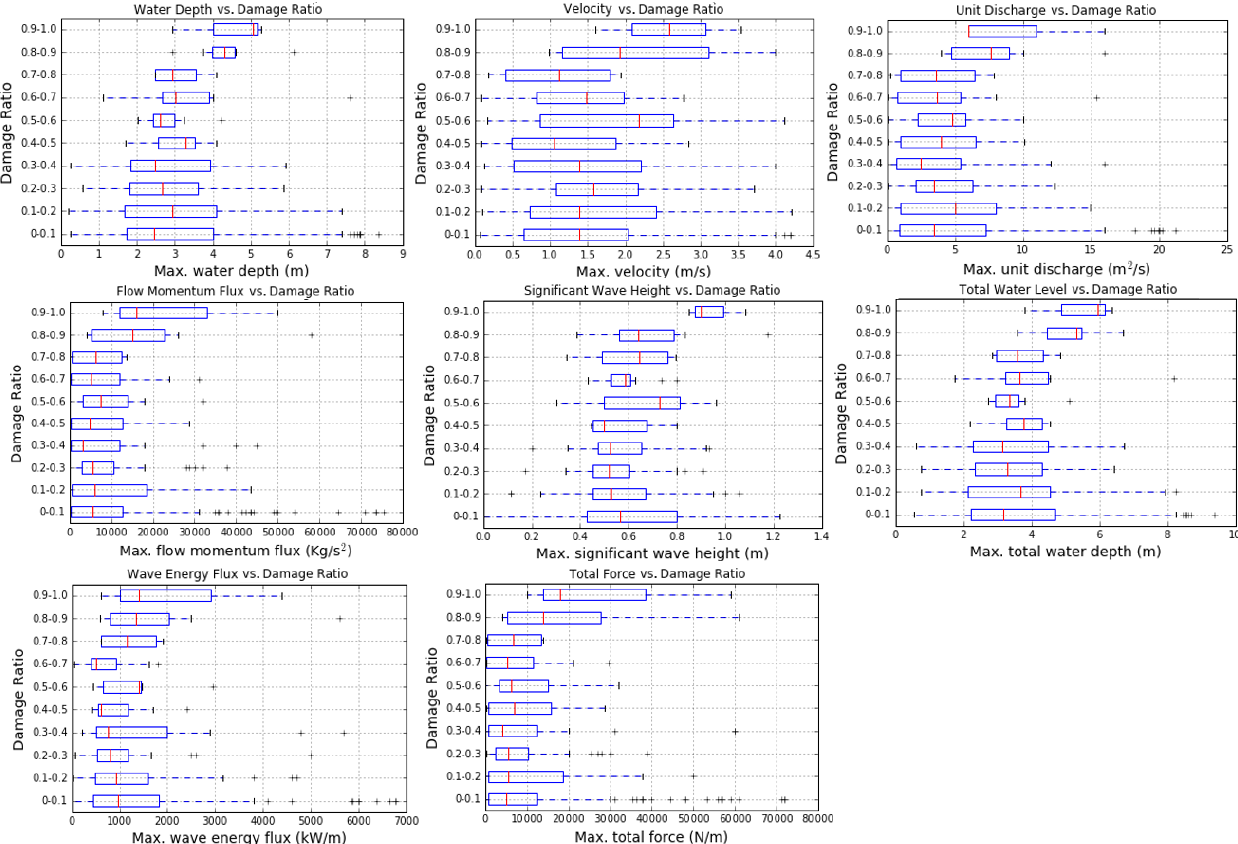
+ ρhv 2 ) with the IGN + structures C g